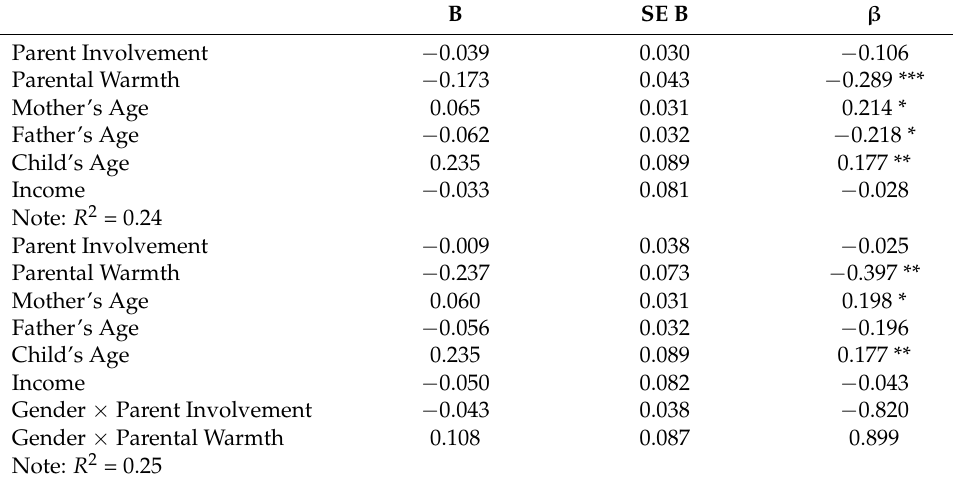
Table 13. Regression with moderators and demographic predictors—behavior